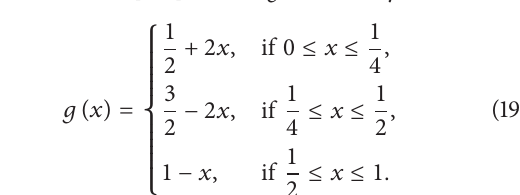
points is, obviously, dense in 𝑆